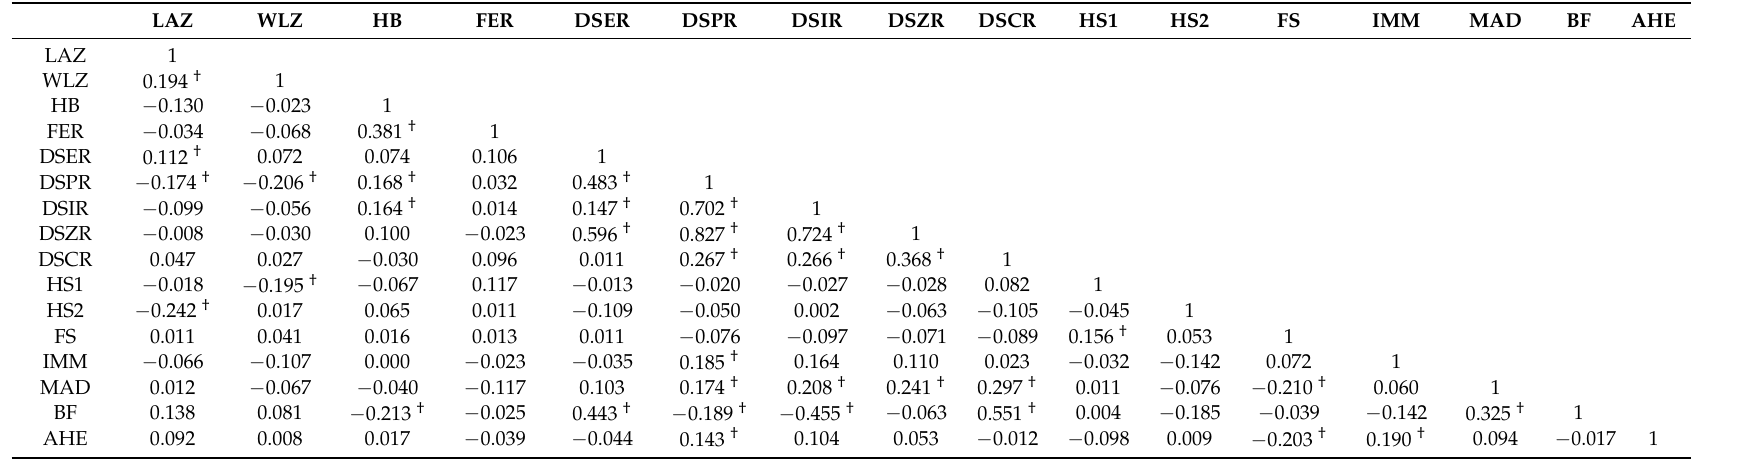
Table 4. Correlation matrix between indicators on nutritional status and its determinants * ( n =